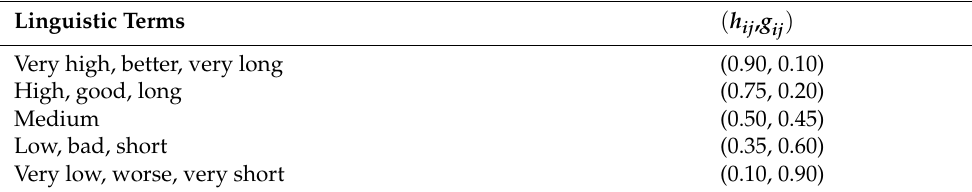
Table 3. The transformation for linguistic